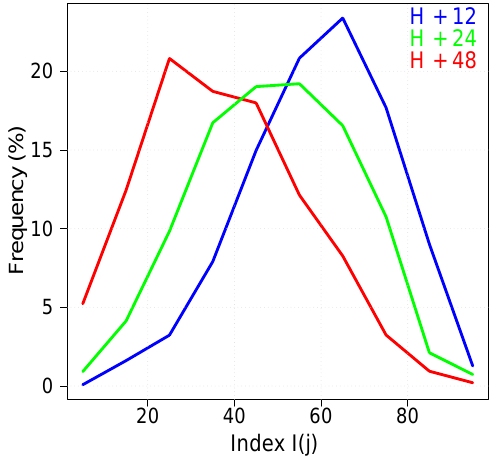
F 3 (j) a partial index ic(j) is defined in order to quantify the Fig. 5. Cyclone distribution as a function of the index value I(j)